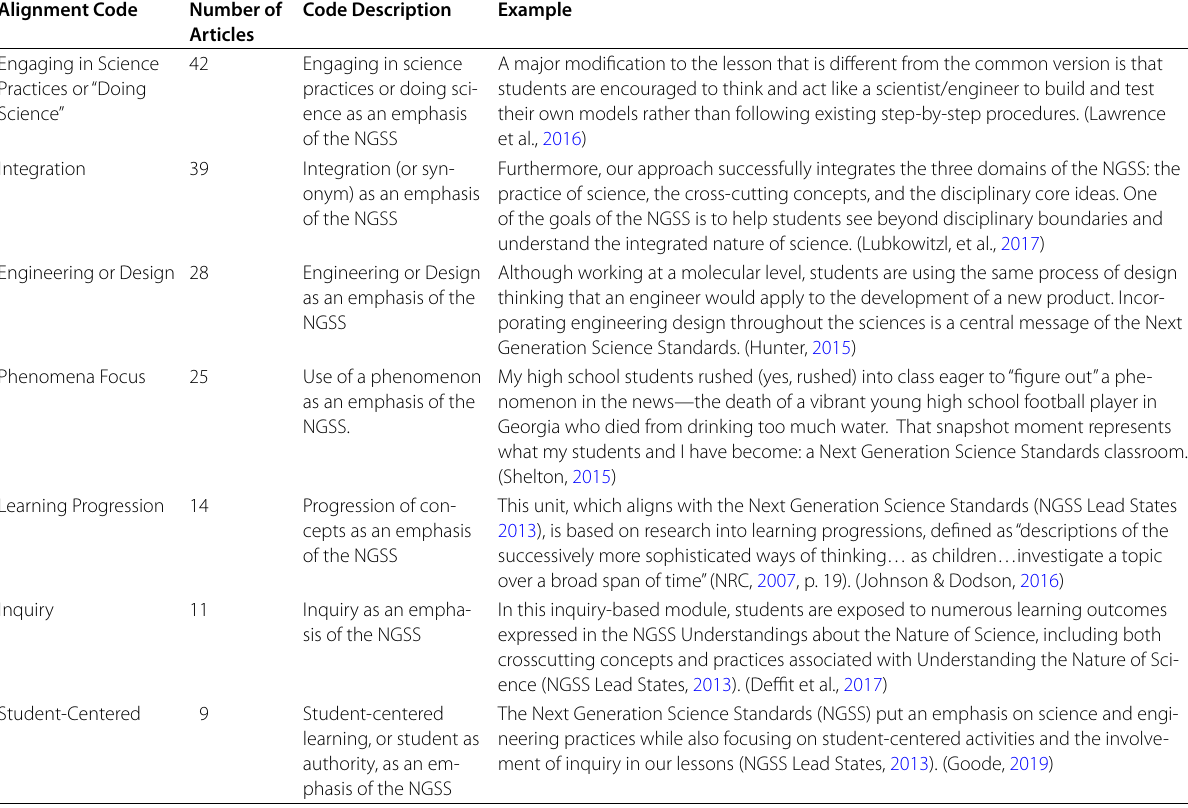
Table 5 Alignment to Broader Reform Ideas: Number of Articles Coded Alignment